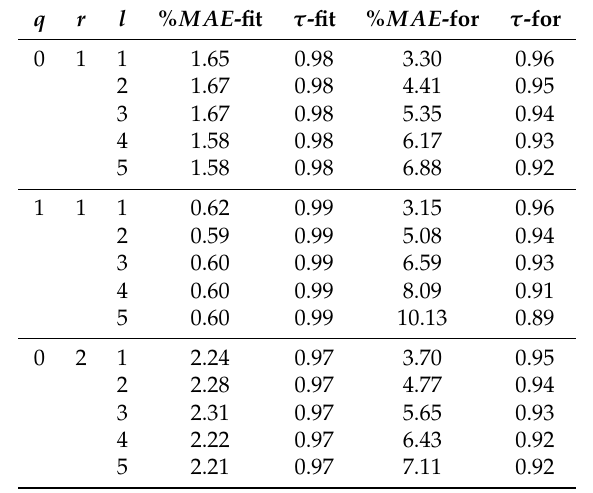
Table 4. Model A: L p -norm Fitting and Forecasting results For p = 1.5, the table shows indices % MAE and Kendall τ correlation for the fitting (columns 4,5 with label fit ) and the forecasting (columns 6,7 with label for ) corresponding to five lags l ∈ { 1,2,3,4,5 } and three pairs ( q , r ) of order q and bandwidth r